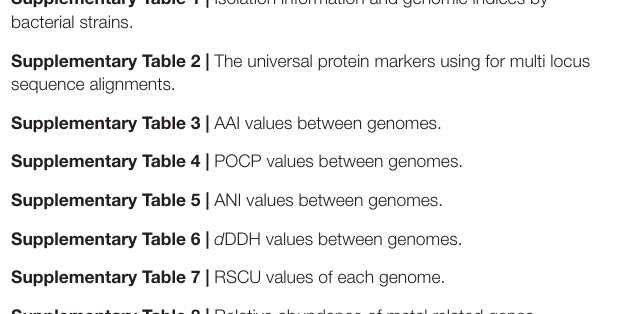
Supplementary Figure 1 | Repetitive clustering and evaluation. Repetitive clustering and evaluation designed to find an appropriate AAI classification value without inclusion of a member in multiple cluster. Subjective intervention was avoided by repetitive clustering and evaluation with gradual increment of cut-off parameter to establish unbiased criteria, not setting strict borders after dividing the genus first. Supplementary Figure 2 | Correlation between AAI and POCP. Red dots represent values between inter-genus strains, and blue dots represent values between intra-genus strains. The color of regression equation in the upper left corresponds to the color of each dot. Supplementary Figure 3 | ANI and d DDH from pairwise whole-genome comparisons. The values of ANI and d DDH were expressed as heatmap. ANI is the lower left triangle indicated in violet color, and d DDH is the upper right triangle indicated in red color. Groups identified as the same species based on ANI and d DDH values are surrounded by black squares. Supplementary Figure 4 | Comparison of the RSCU data of the 27 groups. This figure verifies that there is a distinguishable difference in codon usage between each group. A line plot showing the average value of RSCU for each group. Supplementary Figure 5 | PCA results for metal resistance related gene abundance using z-score normalization. This figure verifies that there is a distinguishable difference in pattern of metal resistance related genes between each group. Supplementary Table 1 | Isolation information and genomic indices by bacterial strains. Supplementary Table 2 | The universal protein markers using for multi locus sequence alignments. Supplementary Table 3 | AAI values between genomes. Supplementary Table 4 | POCP values between genomes. Supplementary Table 5 | ANI values between genomes. Supplementary Table 6 | d DDH values between genomes. Supplementary Table 7 | RSCU values of each genome. Supplementary Table 8 | Relative abundance of metal related